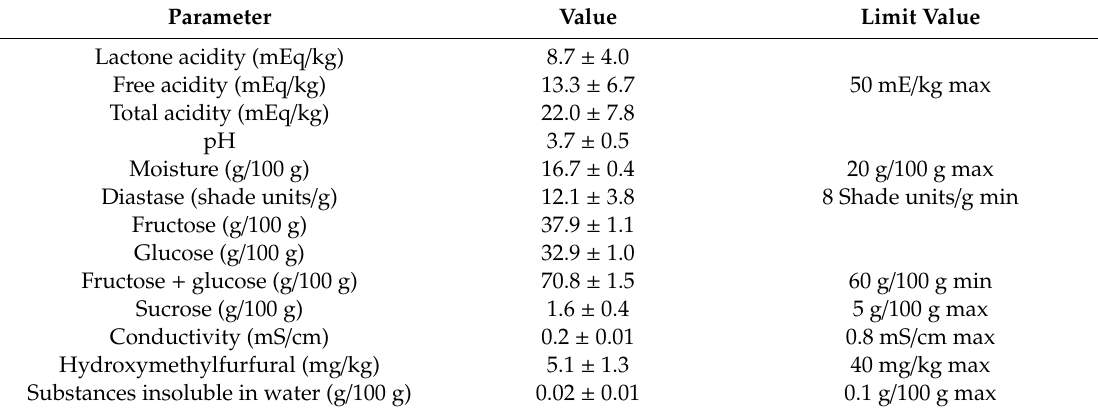
Table 1. Chemical-physical analyses performed on a honey sample taken from one of the beehives where PAS was installed.